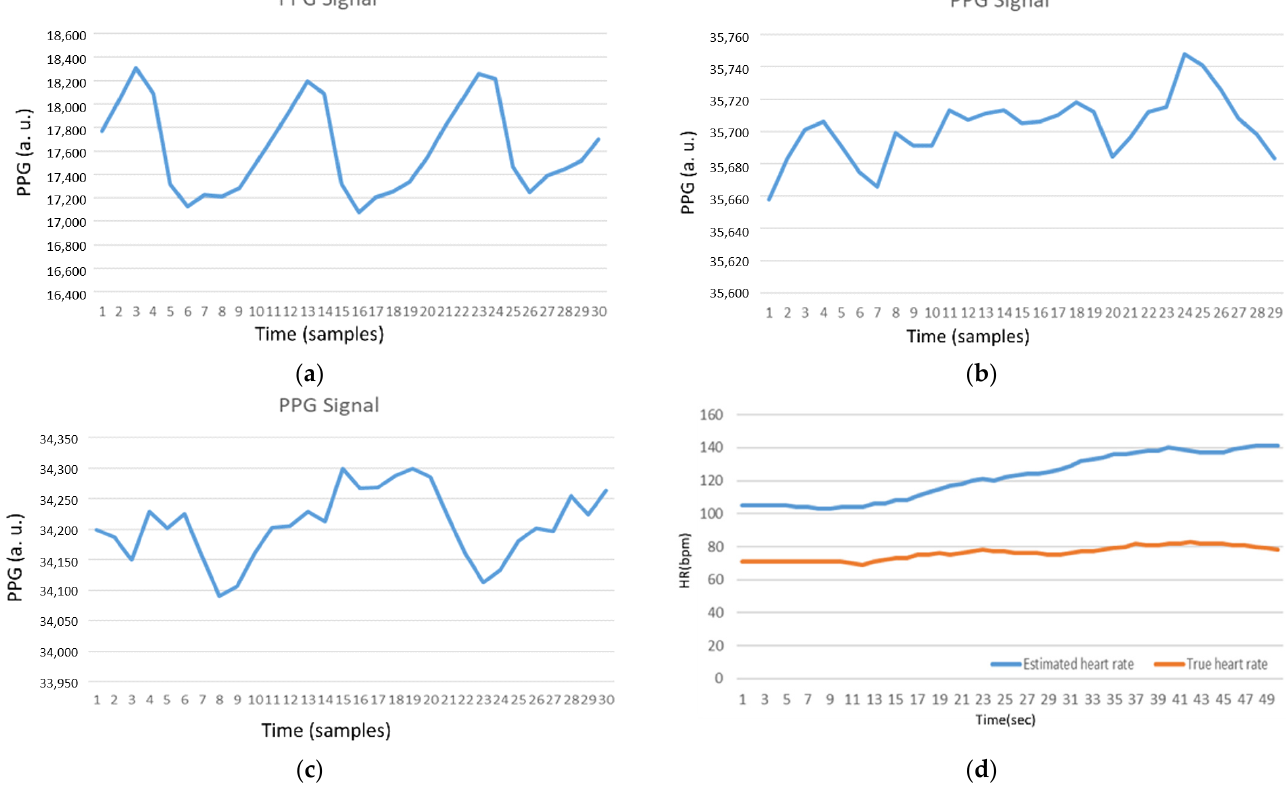
Figure 2. ( a ) Photoplethysmography (PPG) Signal (Finger); ( b ) PPG Signal (Static wrist); ( c ) PPG Signal (Dynamic wrist); and ( d ) Estimated heart rate without preprocessing (Dynamic wrist). Note that the axis names for PPG signals and estimated HRs are (PPG (arbitrary unit) vs. Time (samples)) and (HR (bpm) vs. Time (s)), respectively.